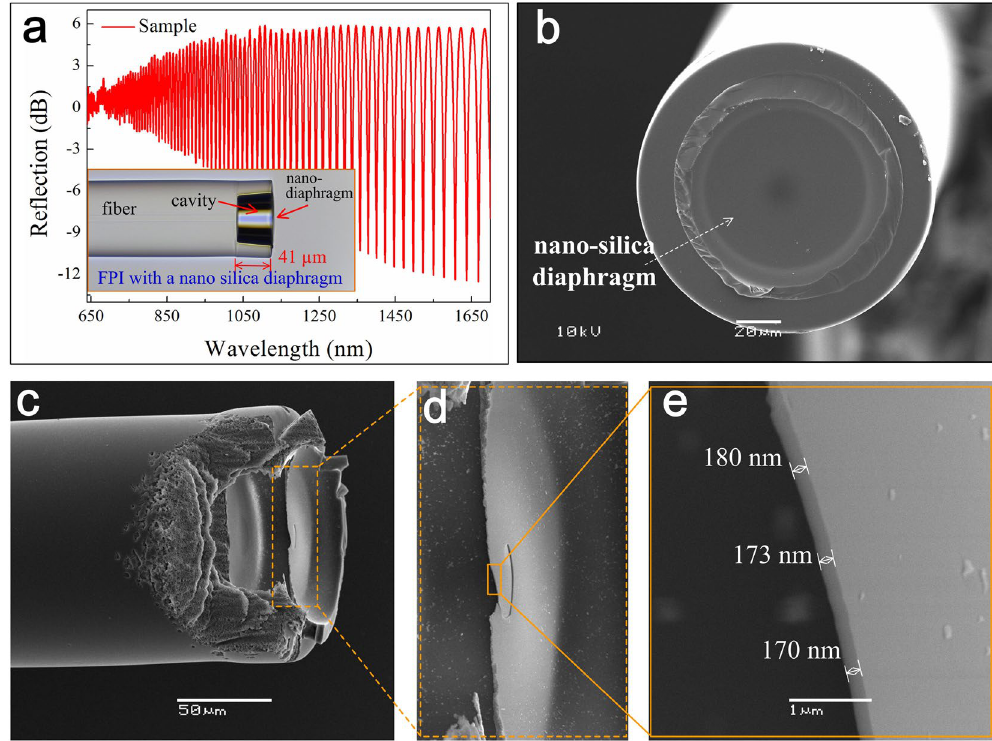
Figure 2. The reflection spectrum ( a ) and SEM images ( b–e ) of an FPI-based gas pressure sensor specimen employing an FDC. The inset of ( a ) presents an optical microscopy image. ( b ) SEM image of the nanometer- scale all-silica diaphragm fused at the end of the silica capillary. ( c ) SEM image of a fractured end of the FDC, while ( d,e ) present enlarged SEM images of the silica diaphragm, showing a sensing diaphragm thickness of about 170